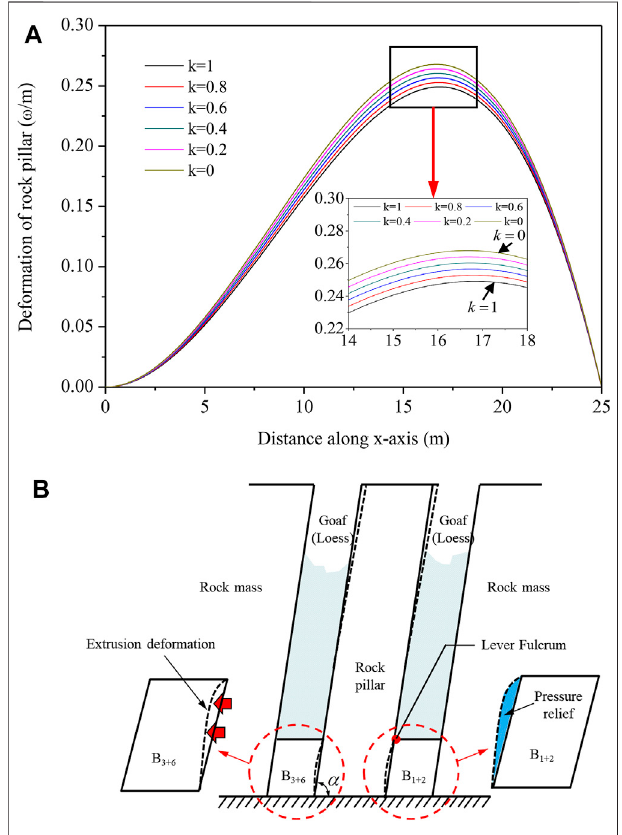
FIGURE4| In fl uence ofrock pillarprying onB3+6coal seam mining. (A) De fl ectioncurveoftheOAsectionoftherockpillarunderdifferent k values; (B) In fl uence of rock pillar prying on the coal seams on both